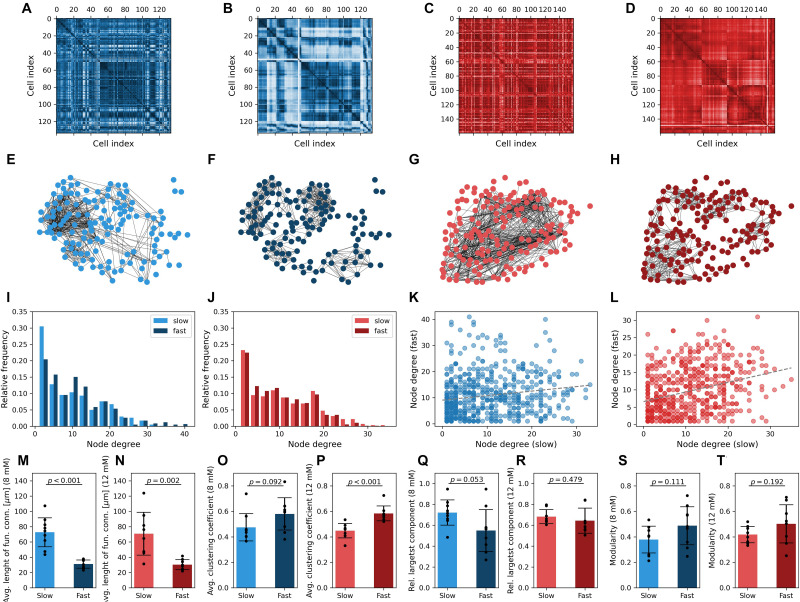
Multiplex network representation and analysis of functional beta cell connectivity maps. Matrix plots of pairwise correlation coefficients in a typical islet stimulated with 8 mM (A,B) or 12 mM (C,D) glucose, separately for the slow (A,C) and fast (B,D) oscillatory components. The corresponding functional beta cell network representation is shown in panels (E–H) for islets stimulated with 8 mM (E,F) and 12 mM (G,H) glucose. Nodes signify positions of beta cells within an islet, and connections stand for functional associations between the slow (E,G) and fast (F,H) oscillatory components. Panels (I,J) display the degree distributions for all islets stimulated with 8 mM (I) and 12 mM (J) glucose, separately for the slow and fast components. Note that the average degree of functional networks in all islets was set to k = 8. The correlation between node degrees in the fast- and slow component derived networks is featured in panels (K,L) for 8 and 12 mM glucose stimulation, respectively. Only nodes with k >  0 were considered. The gray dotted lines represent a linear fit (R2 was 0.15 for low and 0.31 for high stimulatory conditions, p <  0.001). Panels (M–T) feature the average pooled data of network parameters for all islets under the given stimulatory glucose concentration, separately for both oscillatory components: physical length of functional connections (M,N), average clustering coefficient (O,P), global efficiency (R,Q), modularity (S,T). Cohen’s d values: 2.82 (M), 1.86 (N), 0.85 (O), 2.20 (P), 0.98 (Q), 0.36 (R), 0.79 (S), and 0.70 (T).